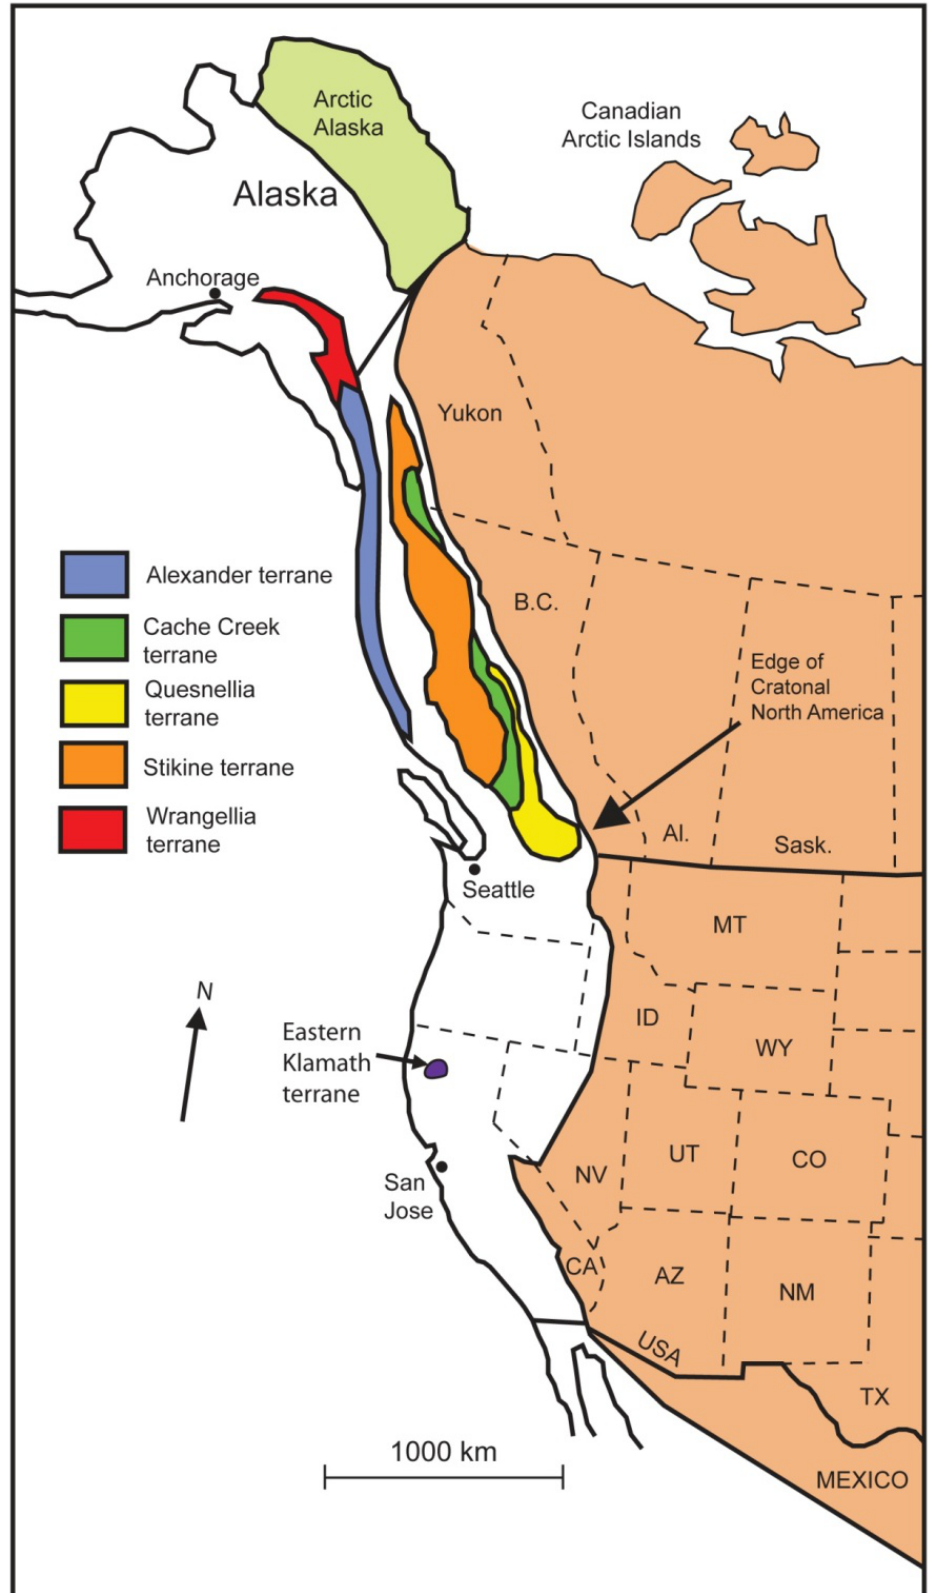
Figure 1. Location of major terranes considered here and approximate western margin of the North American